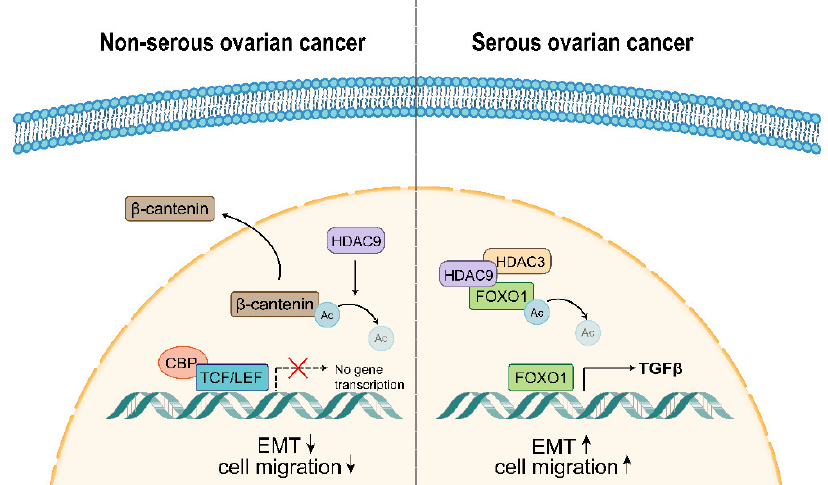
Figure 7. Proposed model by which HDAC9 affects EMT and cell migration in serous and non-serous ovarian cancer. In serous ovarian cancer, HDAC9 promotes TGF-β expression by deacetylating FOXO1 and increasing its nuclear accumulation. Upregulated TGF-β promotes cell migration via activating EMT. In non-serous ovarian cancer, HDAC9 inhibits EMT and cell migration by deacetylating β-catenin and decreasing its nuclear localization. Promote ( → ); Inhibit ( )